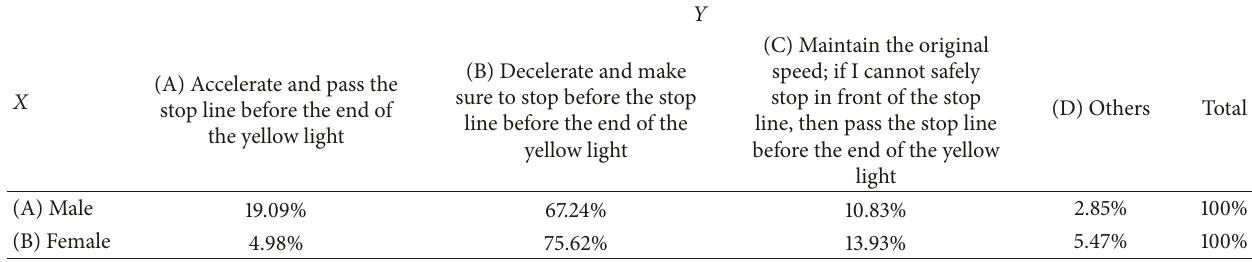
Table 14: Cross-analysis between gender and behavior before the end of the green light at non-countdown signalized intersections. 𝑌 (C) Maintain the original speed; if I cannot safely (B) Decelerate and make (A) Accelerate and pass the 𝑋 stop in front of the stop sure to stop before the stop (D) Others Total stop line before the end of line, then pass the stop line line before the end of the the yellow light before the end of the yellow yellow light light (A) Male 19.09% 67.24% 10.83% 2.85% 100% (B) Female 4.98% 75.62% 13.93% 5.47%